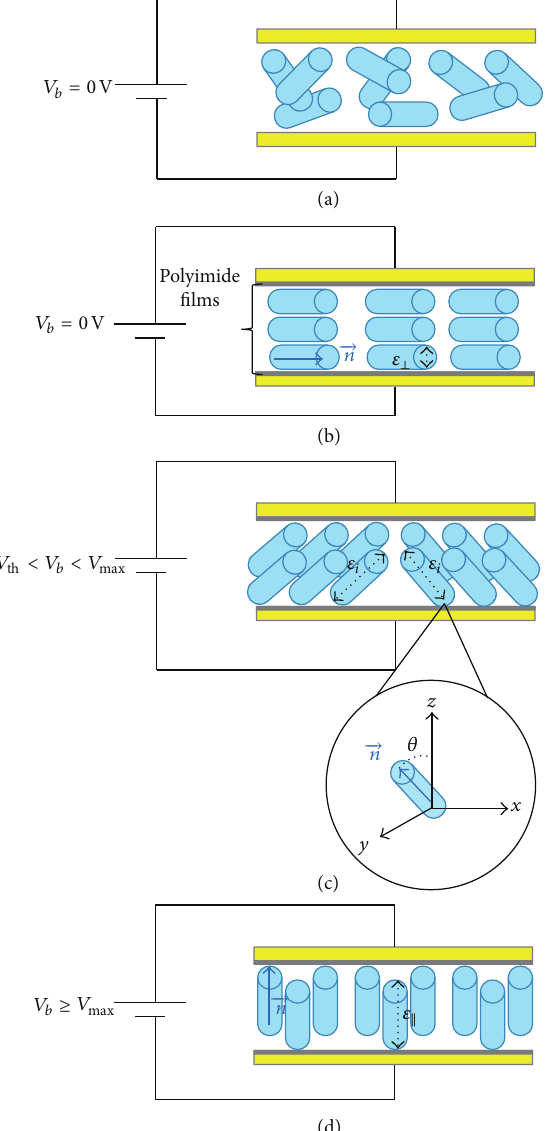
Figure 2: Liquid crystal molecule orientation in different states (a) no-polyimide films, random orientation, (b) polyimide films, perpendicular state ( 𝜀 (d) parallel state ( 𝜀